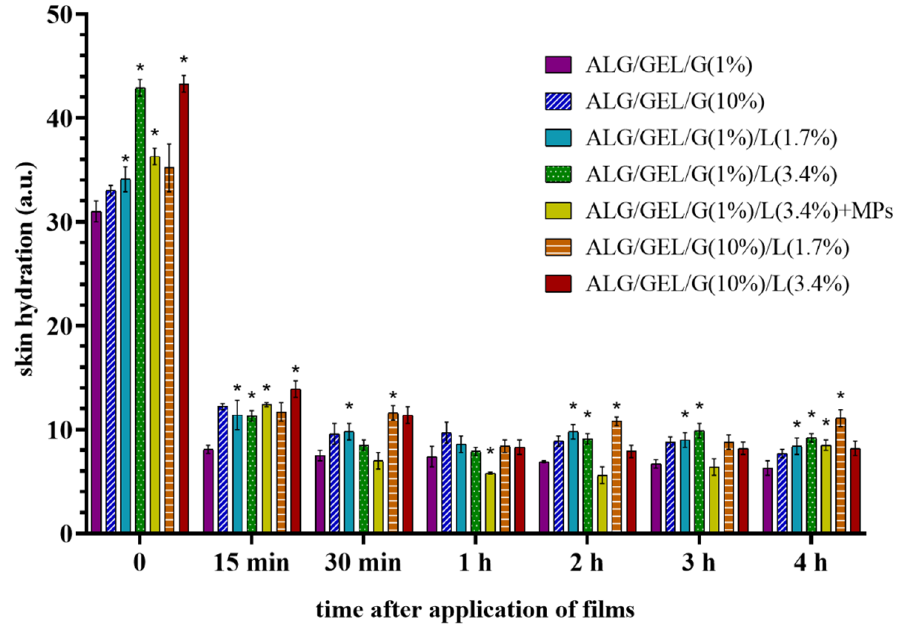
Figure 9. Skin hydration after application of films based on sodium alginate and gelatin with different amounts of glycerol and lipids, as well as the sample with incorporated PLA microparticles. Time = 0 refers to the measurements taken immediately after the removal of films from the skin. The results are the differences in the corneometer indications between the test field and control field at the appropriate point. Significant differences compared to the control samples: ALG/GEL/G (1%) and ALG/GEL/G (10%) for each time were marked on the graphs with (*).